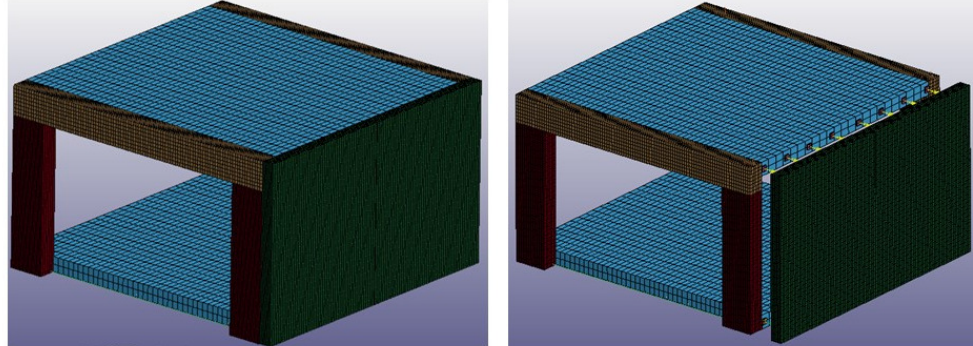
Figure 17. Idealized building structure: façade panel in contact with the protected structure ( left ); façade panel equipped with EACs ( right ).